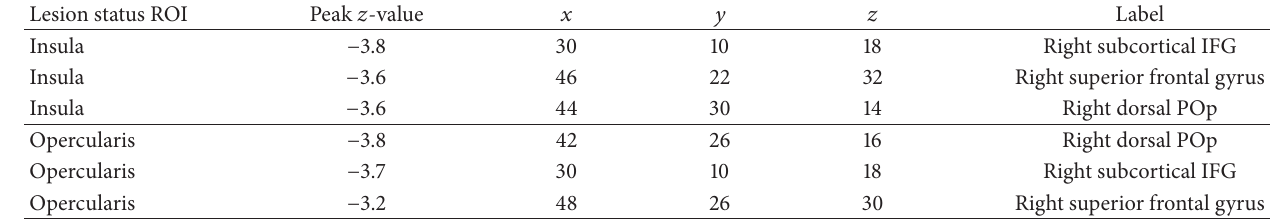
Table 6: Areas where decreased activity was related to lesions in the left frontal lobe ROIs.